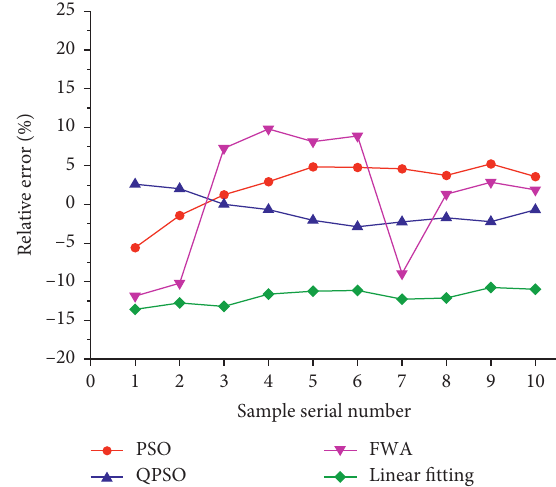
4 by using different models.